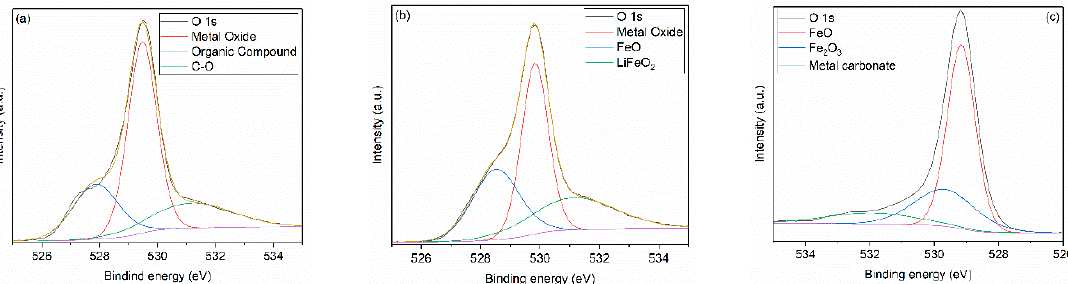
◦ C, ( b ) 800 ◦ C, and ( c ) 1000 ◦